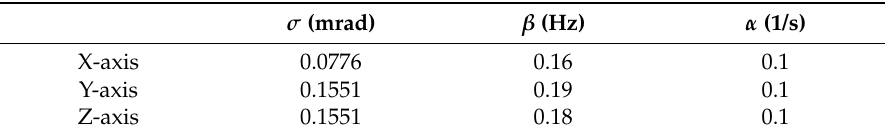
Table 1. Model parameters of dynamic misalignment